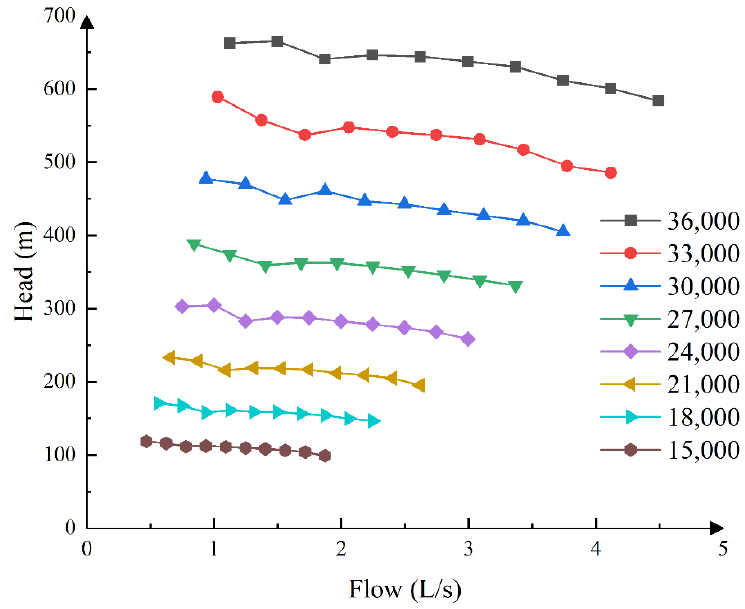
Appl. Sci. 2022 , 12 , 6441 Figure 6. Pump head vs. flow curve under different speeds. Figure 6. Pump head vs. flow curve under different speeds.